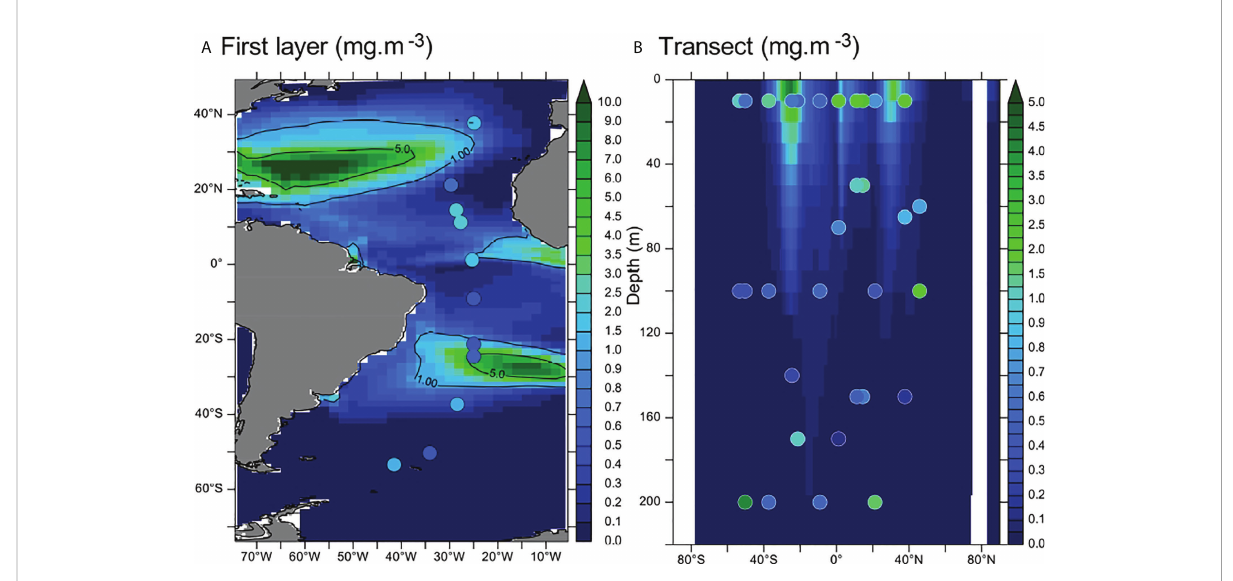
FIGURE 1 (A) Comparison of modeled total [MP] (background colors) with in situ measurements from Pabortsava and Lampitt (2020) (dots) in the fi rst layer (0 – 10 m, mgMP·m − 3 ). (B) Modeled MP concentrations (background, mg·m − 3 ) and measured concentrations (dots) along the vertical transect. The modeled concentrations reported on panel ( B ) (background) are averaged between 30°W and 20°W. Contour lines indicate 1 and 5 mgMP·m − 3